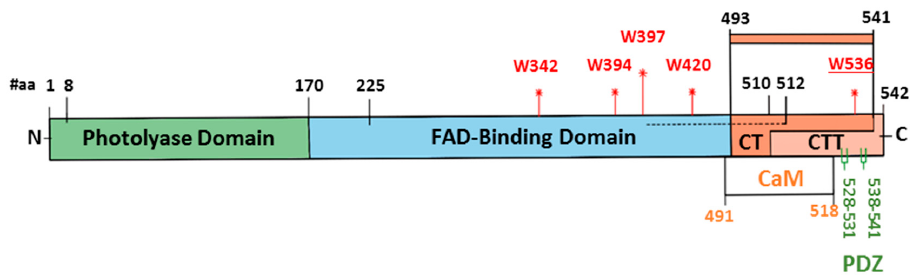
Figure 2. Representation of the key regions, motifs and residues in Drosophila CRY. Respective positions of structural elements/motifs are shown by amino acid number (#aa). Key regions include N-terminal Photolyase Domain (1-170aa), FAD-Binding Domain (171-512aa), and the C-terminus (CT) (493-541aa), which encompasses the important regulatory region of the C-terminus tail (CTT) (510-542aa). Tryptophan (W) residues implicated to support the canonical radical pair mechanism (RPM) are shown in red (although W536 is a residue of interest, it is yet to be investigated). Calmodulin-binding (CaM) (491-518aa) and PDZ (528-531 and 538-541) domains are present in the CTT. These are of particular interest as nucleation points for the recruitment of interactors and downstream signalling partners.